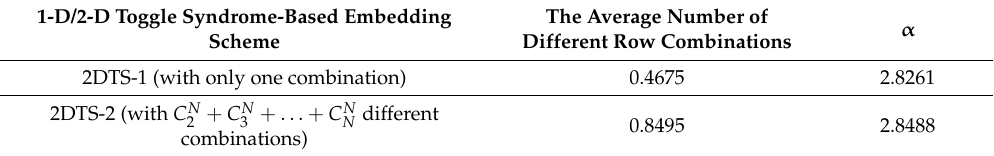
Table 4. Comparison of computational complexity between 2DTS-1 and